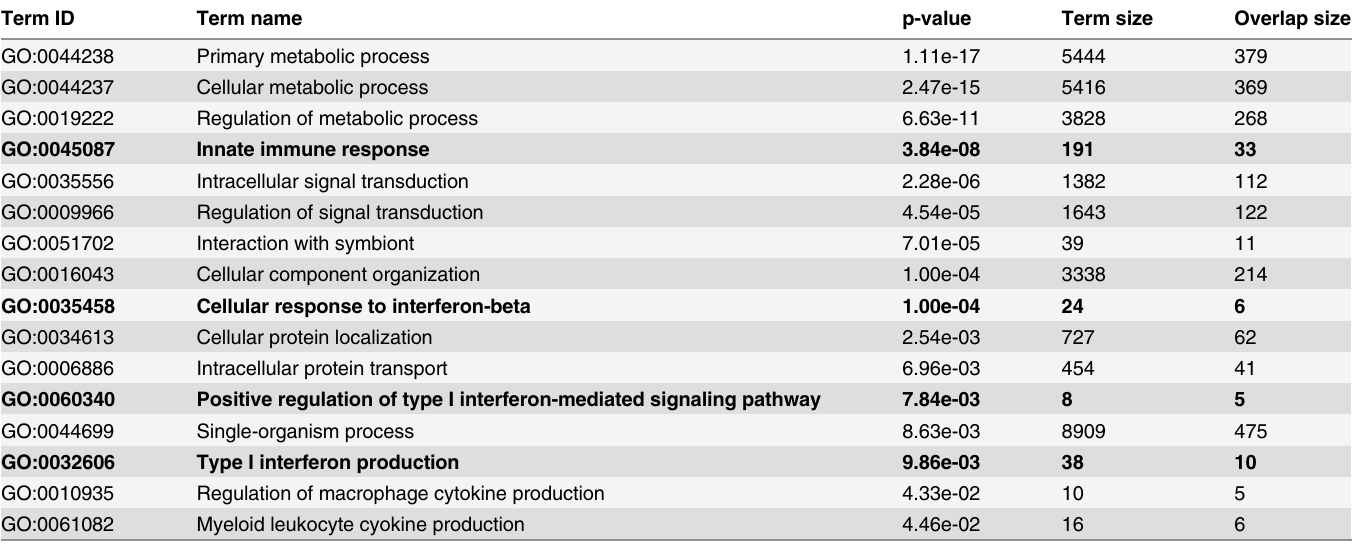
Table 1. Functional analysis of Sp1